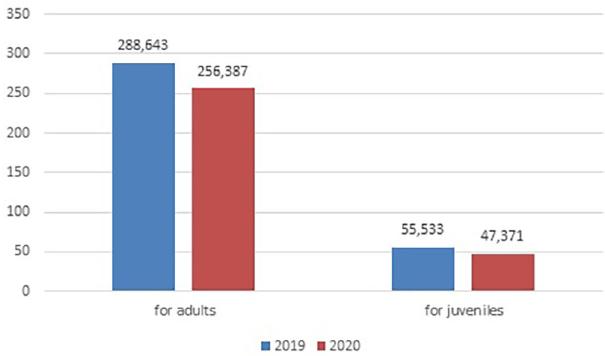
Figure 1. Comparation of new cases in the probation system reported between 2019 and 2020. Source: Own analyzes based on the statistics of the Ministry of Justice, Department of Strategy and European Funds, MS-S40r Report on the activity of the probation court service for the year 2019, 2020. Warszawa.